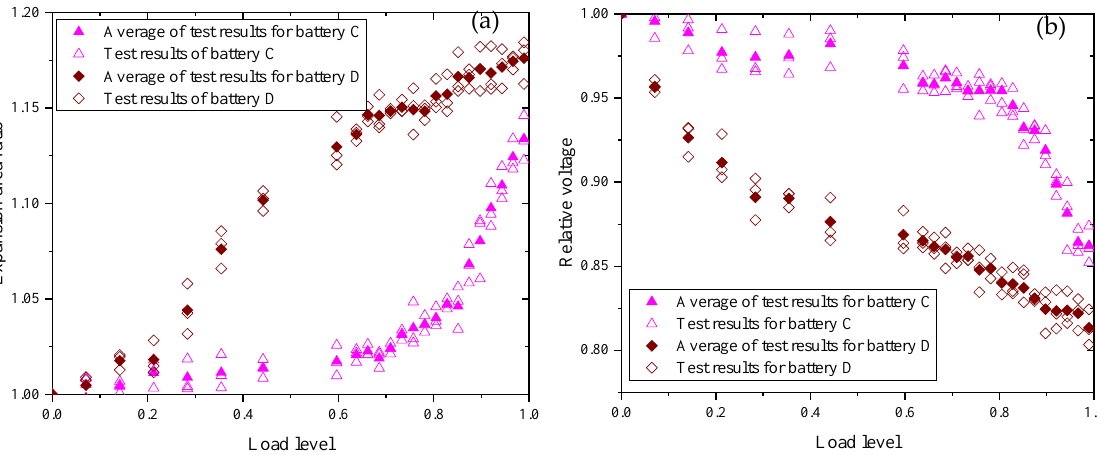
Figure 8. Effect of load level on battery deformation and voltage: ( a ) expansion area ratio, and ( b ) relative voltage.